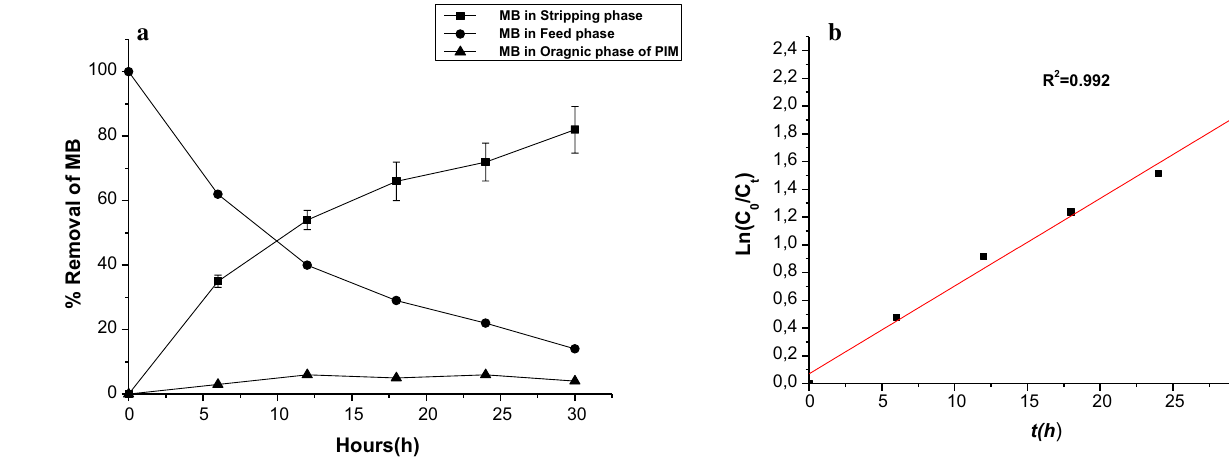
tion with pH 11.0; strip phase:0.3 M HCl solution; Membrane: 0.05 g RC8/g CTA + 0.4 mL 2-NPOE)